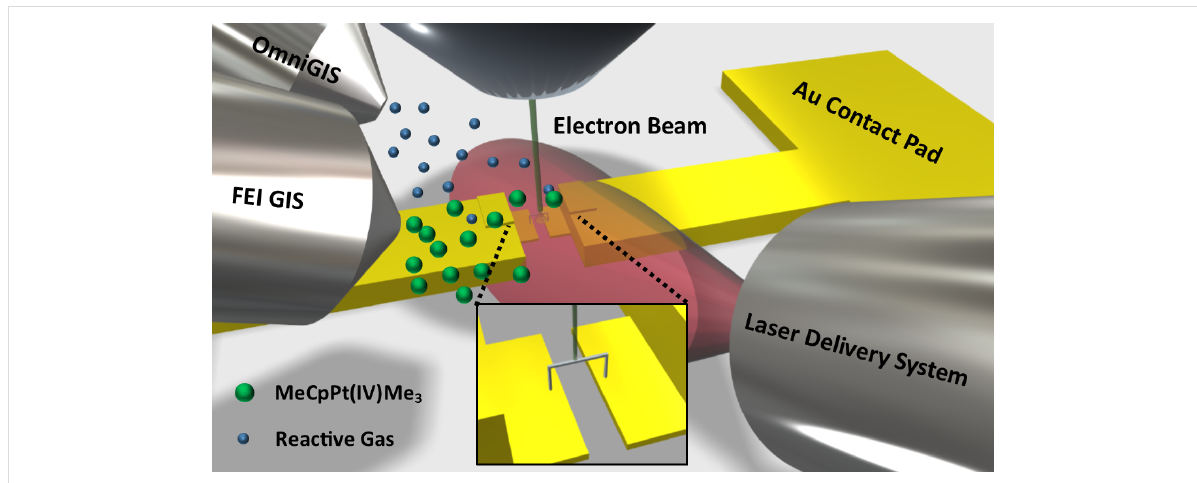
Figure 1: Schematic illustrating the experimental system which includes a laser delivery system, precursor and co-reactant gas delivery systems, and the electron beam all coincident to the same region. The schematic also illustrates the deposition of the 3D suspended bridge structures grown for the electrical